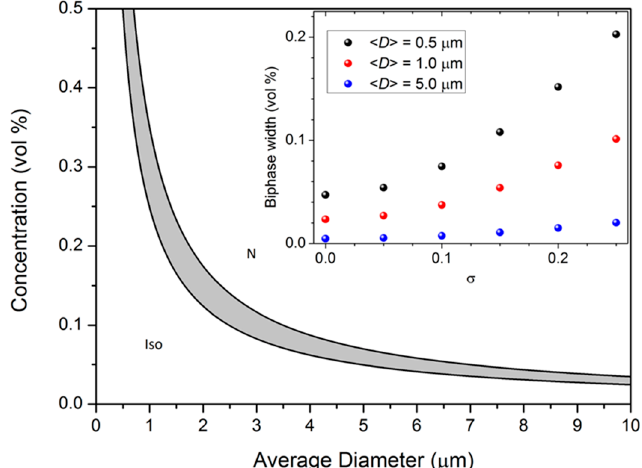
Figure 5. The phase diagram for a hard-disk fluid with 25% polydispersity from simulations by Bates and Frenkel. The isotropic (Iso) and nematic (N) phases are labelled and the shaded part corresponds to the biphasic region. Inset: the effect of polydispersity on the width of the biphase. When the concentration of graphene oxide is further increased, other phases can be